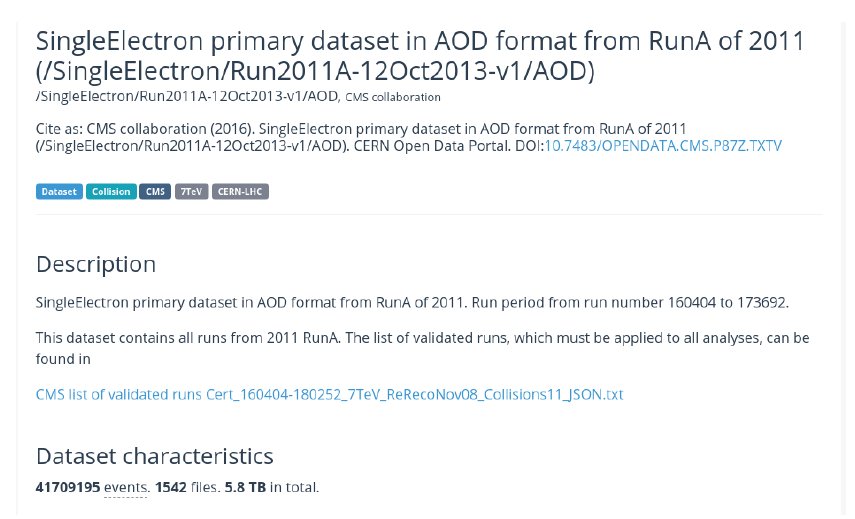
Figure 5. Example of a reconstructed AOD dataset released on the CERN Open Data portal. A part of this dataset comes from the RAW data sample from Figure